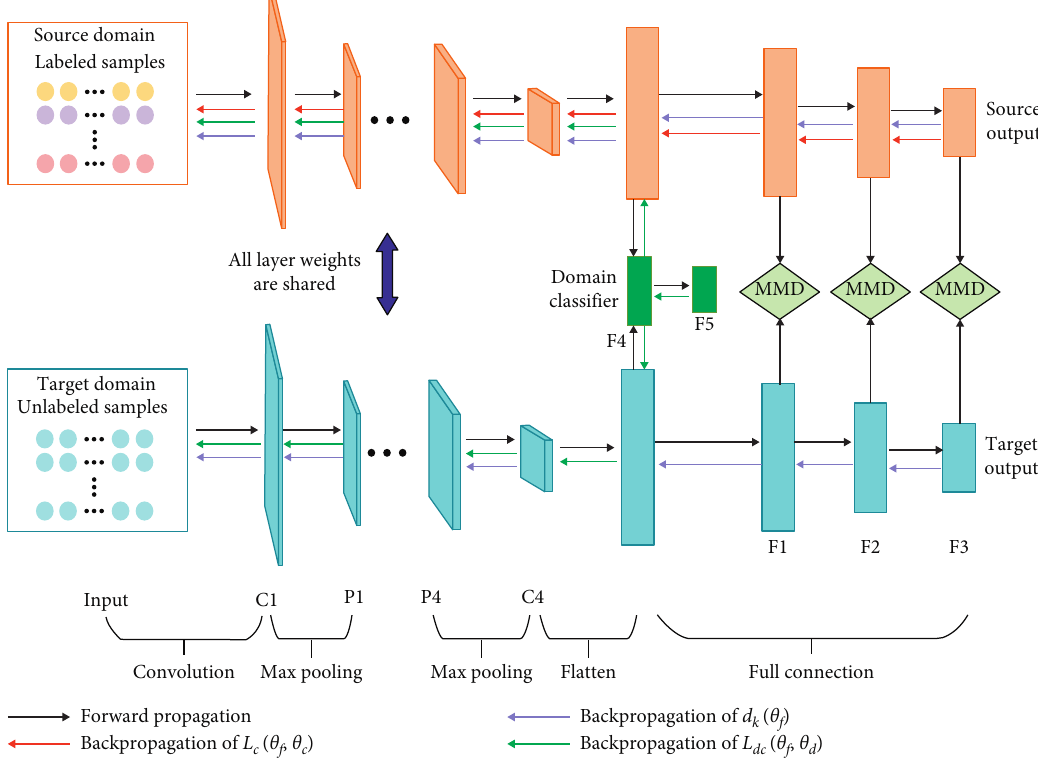
Figure 2: Architecture of the proposed DCDAN model.